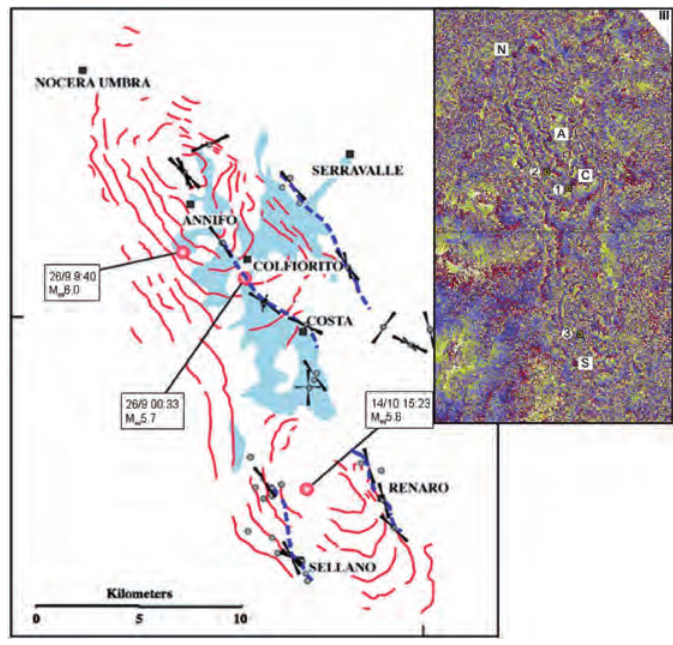
Fig. 13 . Inferred zones of surface fractures (blue dashed lines) and interpreted interferometric fringes from Salvi et al . (2000) (modified from Cinti et al ., 2000). Each contour line indicates an increase of the satellite-to-ground distance of 28 mm. A maximum increase (subsidence) is in and north of the epicentral areas. To the right: Differ- ential interferogram of the entire sequence by Salvi et al . (2000). Each contiguous inward colour cycle represents a displacement increment of –28 mm. Symbols: 1 = “00:33” 26 September earthquake; 2 = “09:40” 26 Septem- ber earthquake; 3 = “15:23” 14 October earthquake; A = Annifo; N = Nocera Umbra; C = Colfiorito; S =